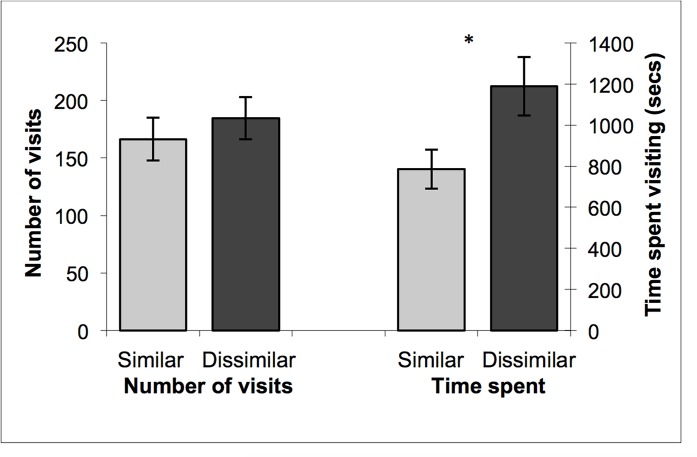
The number of visits and time spent at male doors.The mean (± SE) number of times female agile antechinus (n = 28) visited the doors of males that were more genetically similar and more dissimilar to themselves (left) and the mean (± SE) time (seconds) female agile antechinus (n = 28) spent visiting the doors of males that were more genetically similar and more dissimilar to themselves (right). An asterisk (*) indicates a significant difference from the other value (p = 0.003).